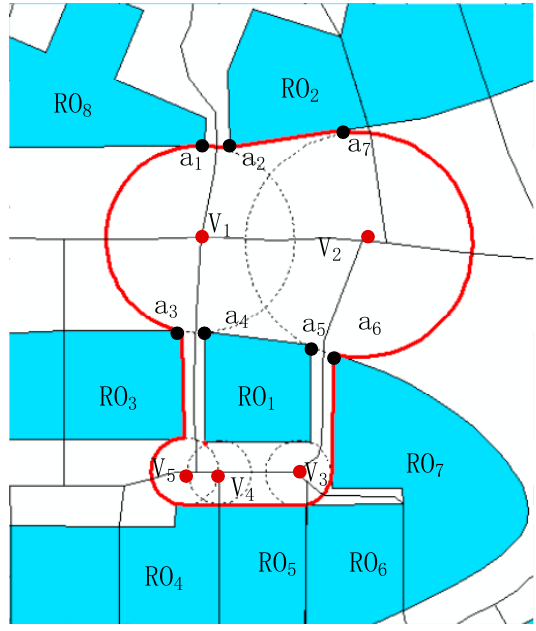
Figure 3. The process of obtaining near boundary RO 1 .